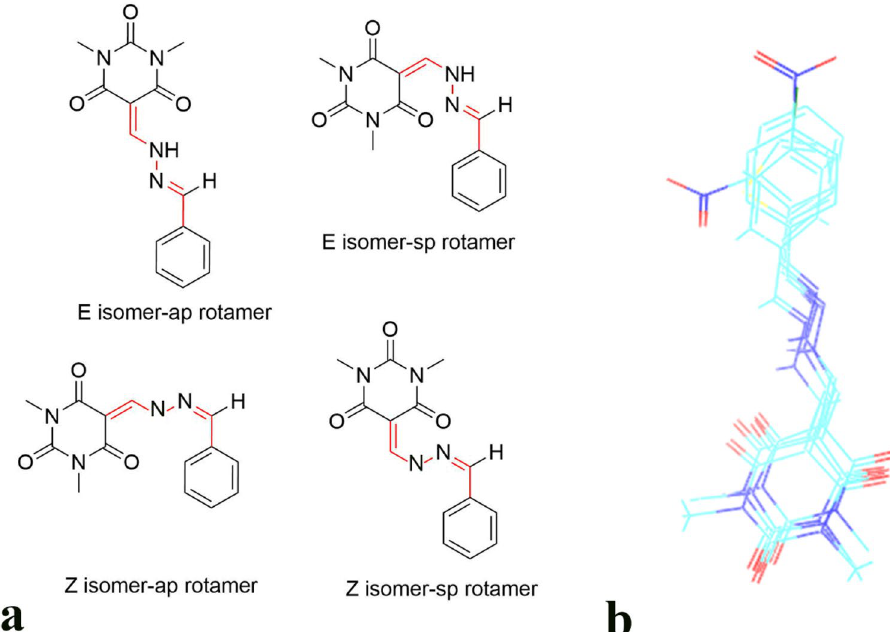
Figure 7. Four possible configurations of benzylidene hydrazone moiety of the synthesized compounds ( a ). Superimposition of the docked structures in the active site of urease ( b ). The 2D structure representation was drawn by ChemAxon Marvin 15.10.12.0 30 .